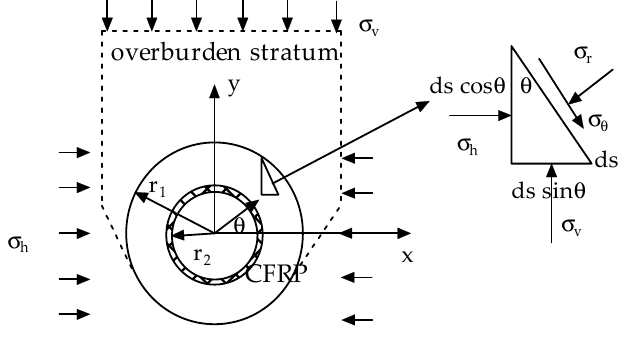
Figure 1. The inner-adhesive-type CFRP for tunnel